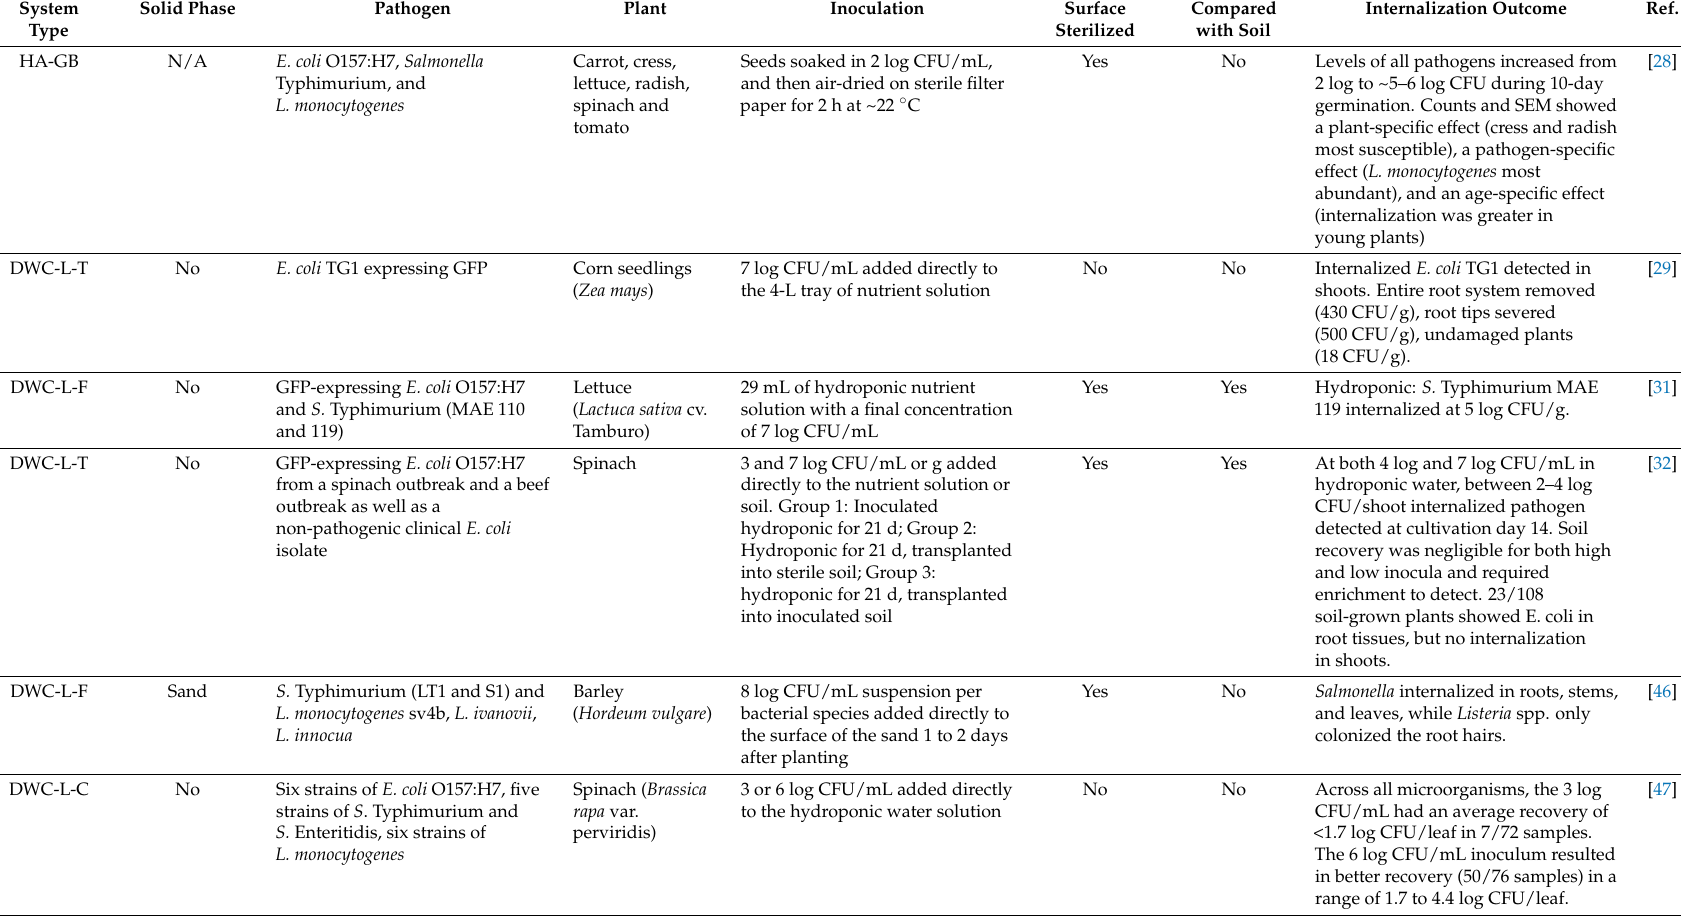
Table 2. Investigations of pathogen internalization in leafy greens grown hydroponically by system